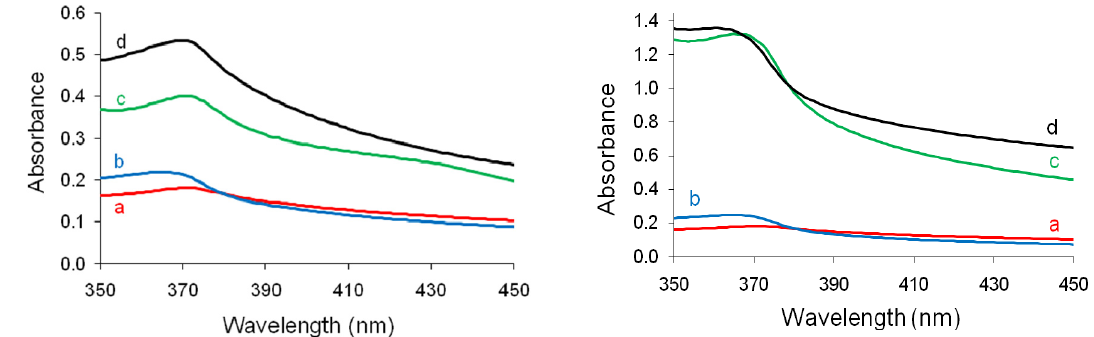
Figure 9. Left: UV–vis spectra of ZnO NPs obtained without PyQAs1 ( a ) and with 1% ( b ), 2.5% ( c ), and 5% ( d ) PQAs1. Right: UV–vis spectra of ZnO NPs obtained without PyQAs2 ( a ) and with 1% ( b ), 2.5% ( c ), and 5% ( d ) PyQAs2.